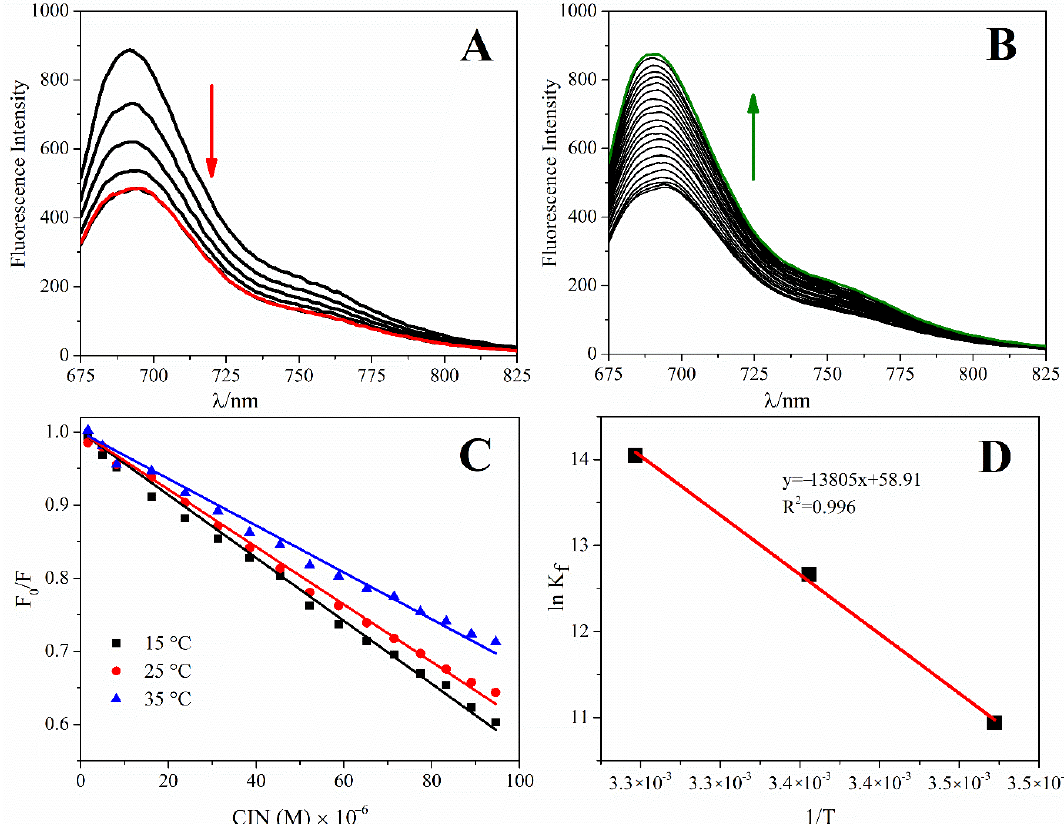
Figure 5. ( A ) Fluorescence spectra of MB-ct-dsDNA titration, ( B ) CIN – MB+ct-dsDNA titration in ABS (pH 4.70), λ exc: 665 nm, the concentration of MB: 50 µ M, the concentration of the stock solution of ct-dsDNA: 100 µ g mL − 1 , ( C ) The Stern–Volmer curves at different temperatures, ( D ) Van’t Hoff plots of CIN-ct-dsDNA Table 1. Stern – Volmer constants, binding constants, binding sites, and thermodynamic parameters.